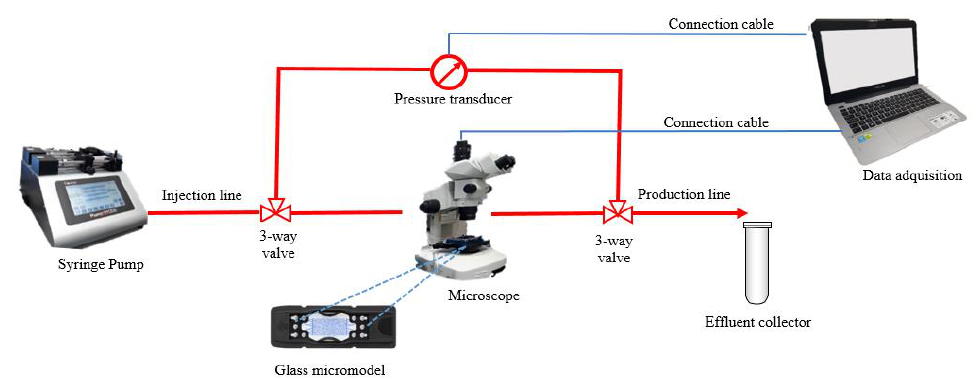
Figure 2. Diagram of the micromodel flooding setup.